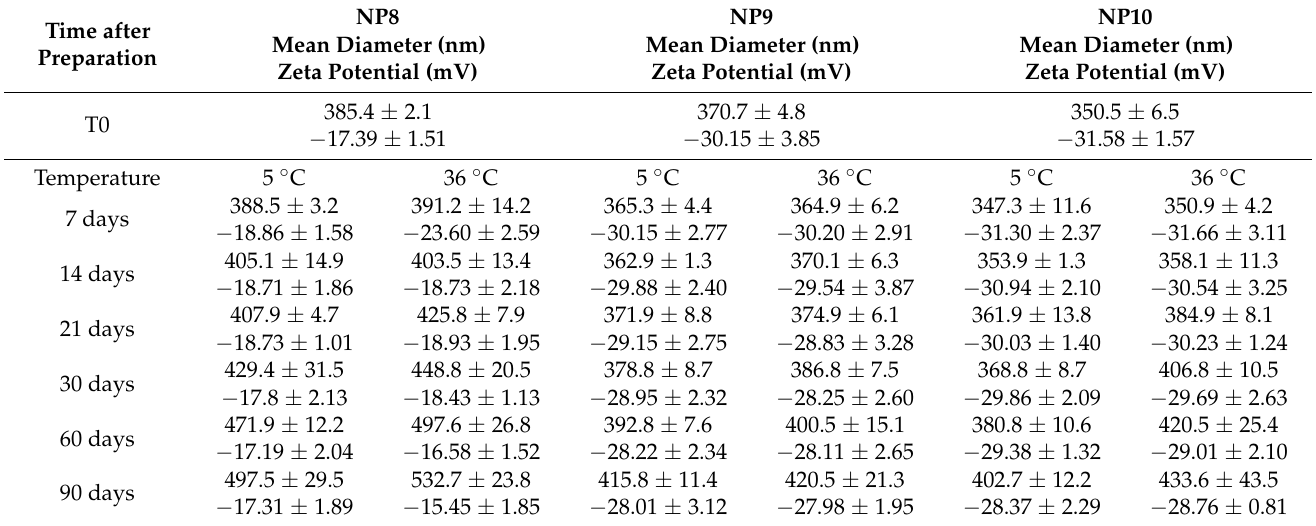
Table 4. Sizes and Zeta potentials of NP8, NP9, and NP10 for up to 90 days.